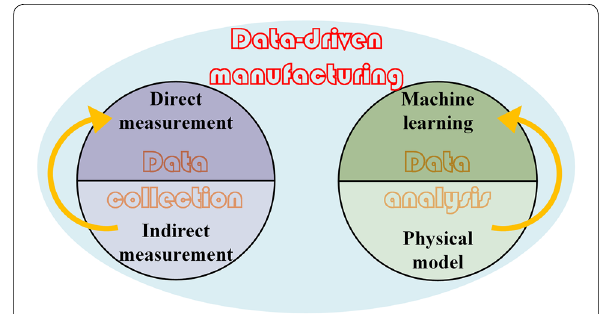
Figure 7 Evolution of data-driven